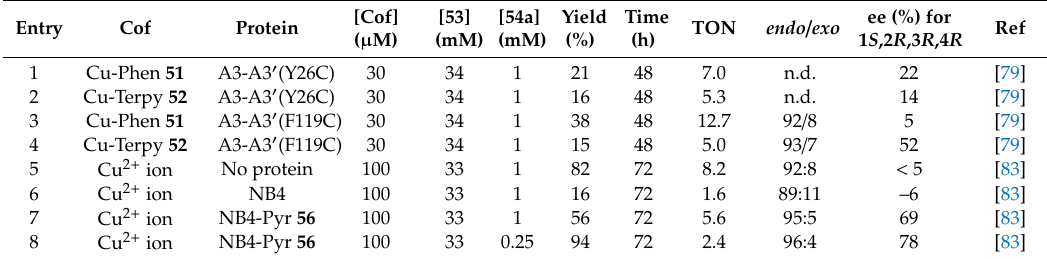
Table 4. Selected results of Diels–Alder reactions catalyzed by artificial copper enzymes [79,83]. Cof